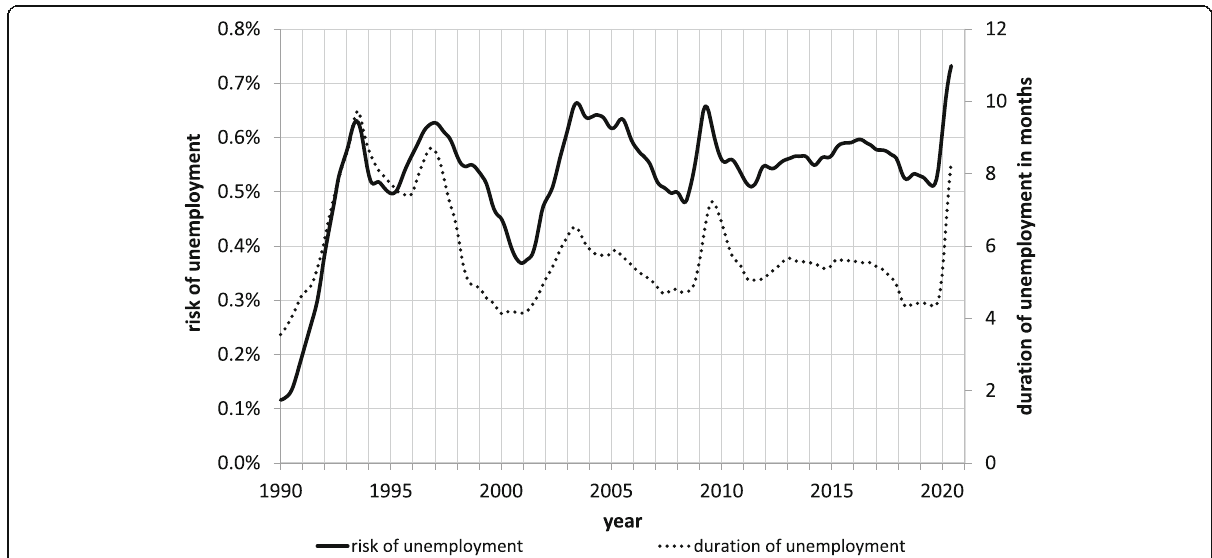
Fig. 2 Risk and duration of unemployment, seasonally adjusted, January 1990-June 2020. Notes: The risk of unemployment measures the probability of becoming registered unemployed in a given calendar month and equals the number of individuals entering registered unemployment in that month divided by the current size of the labor force according to official registered unemployment statistics. The duration of unemployment gives the number of months that cohorts entering registered unemployment can expect to remain in this state and corresponds to the area under the survivor curve of the corresponding month calculated using Eq (2) and the computerized database underlying the official registered unemployment